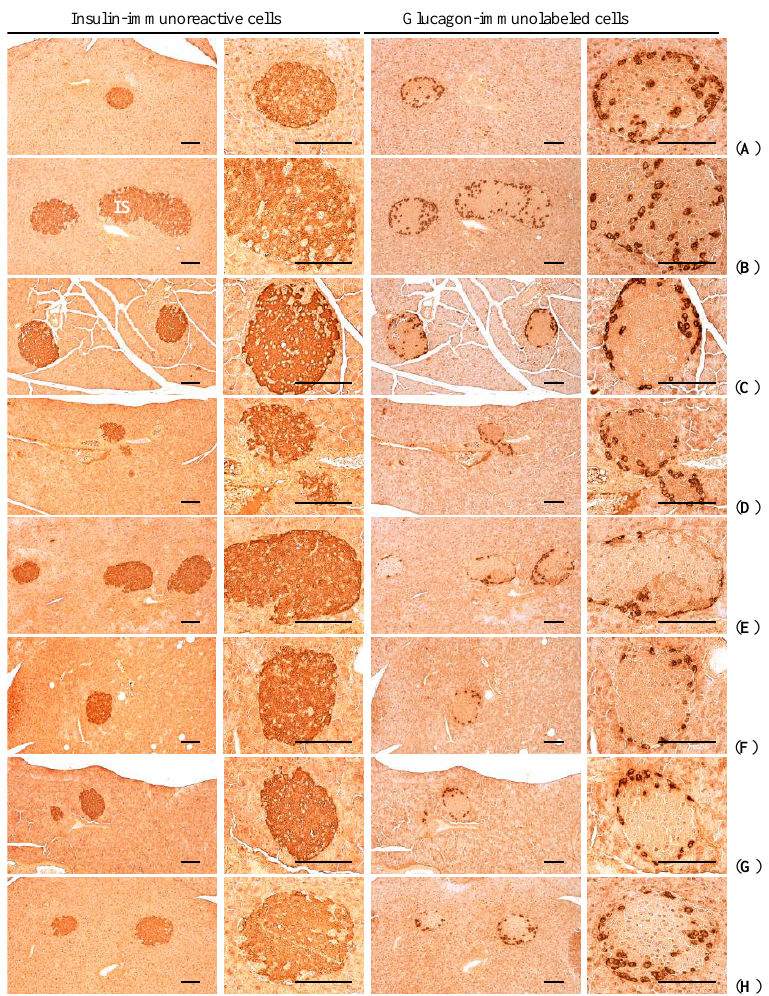
Figure 6. Representative histological images of the insulin- and glucagon-immunoreactive cells in the pancreas, taken from NFD or HFD supplied mice. ( A ) Intact control: Normal pellet diet supplied vehicle control mice; 10 mL/kg of distilled water oral administered mice; ( B ) HFD (vehicle) control: 10 mL/kg of distilled water oral administered mice with HFD supply; ( C ) Simvastatin: 10 mg/kg of simvastatin oral administered mice with HFD supply; ( D ) Metformin: 250 mg/kg of metformin oral administered mice with HFD supply; ( E ) GT400: 400 mg/kg of GT oral administered mice with HFD supply; ( F ) fGT400: 400 mg/kg of fGT oral administered mice with HFD supply; ( G ) fGT200: 200 mg/kg of fGT oral administered mice with HFD supply; ( H ) fGT100: 100 mg/kg of fGT oral administered mice with HFD supply. NFD, normal fat pellet diet; HFD, high fat diet; GT, green tea extracts; fGT, Aquilariae lignum -fermented green tea extracts. All immunostained by avidin-biotin-peroxidase complex. Scale bars = 80 µ